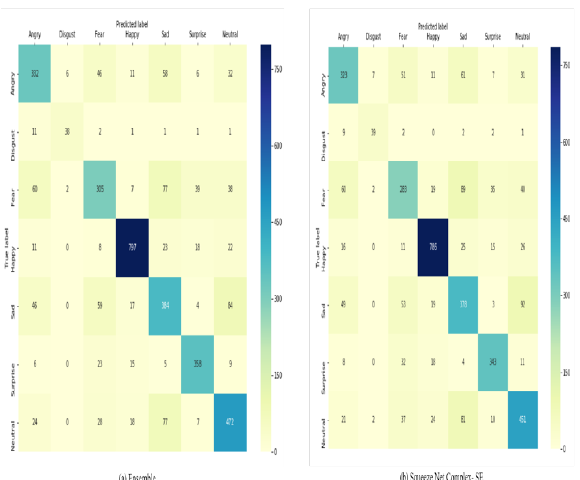
Figure 16 . Confusion Matrix for FER2013: (a) Inception-ResnetV1 (b) SqueezeNet SE.